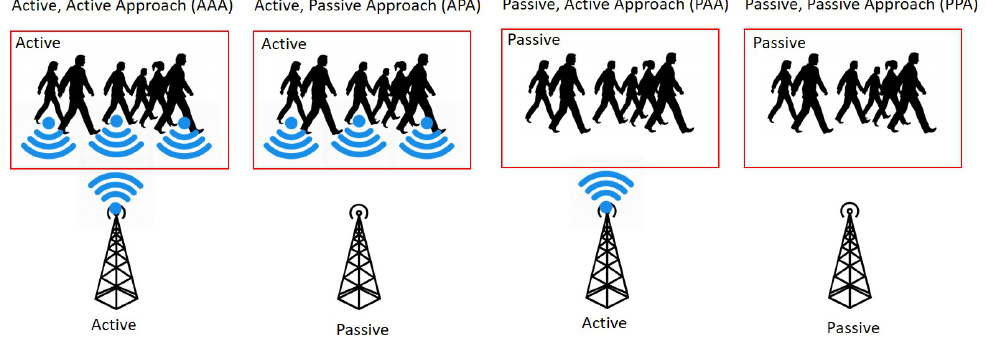
Figure 6. BLE Scanning